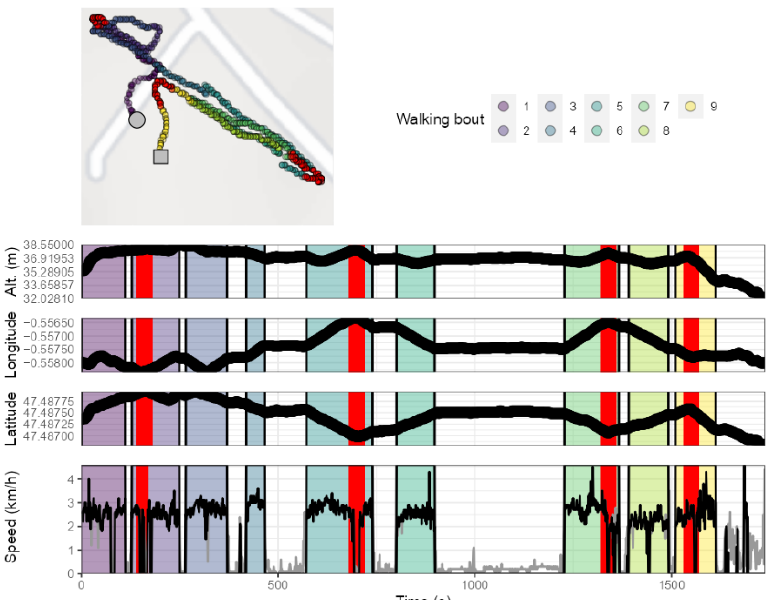
Figure 5. Illustrations of the methodological issues observed during GPS data analysis (here for Participant #3). The figure is one of the two examples without a clearly visible initial resting phase. The figure also shows that several parts of the proposed walking course (highlighted in red on the map), which were very steep turns, were related to a drop in walking speed. Grey lines depict raw speed values obtained with the GPS device and that were transformed following the speed data processing procedure. Alt. = altitude.